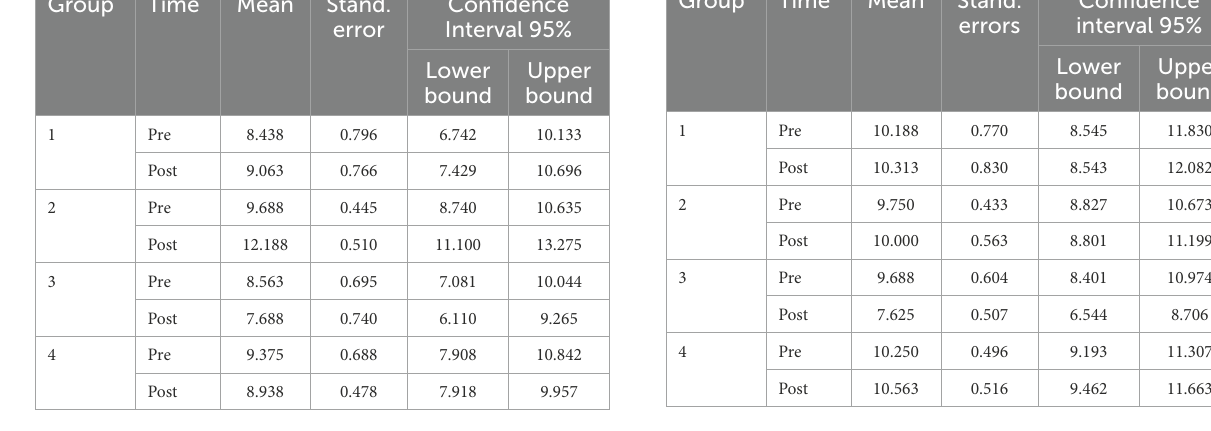
TABLE 13 Fear of minor pain means by comparing groups and time. Group Time Mean Stand.